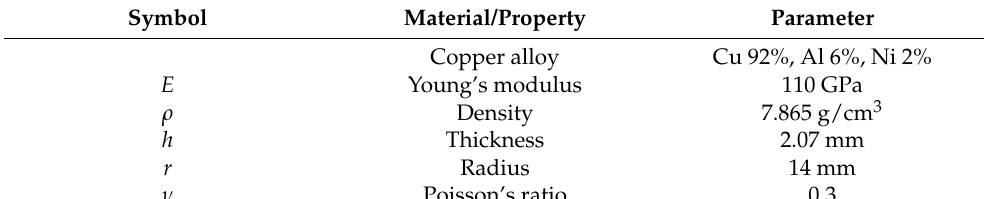
Table 2. Technical parameters for the 50 NTD coin. Symbol Material/Property